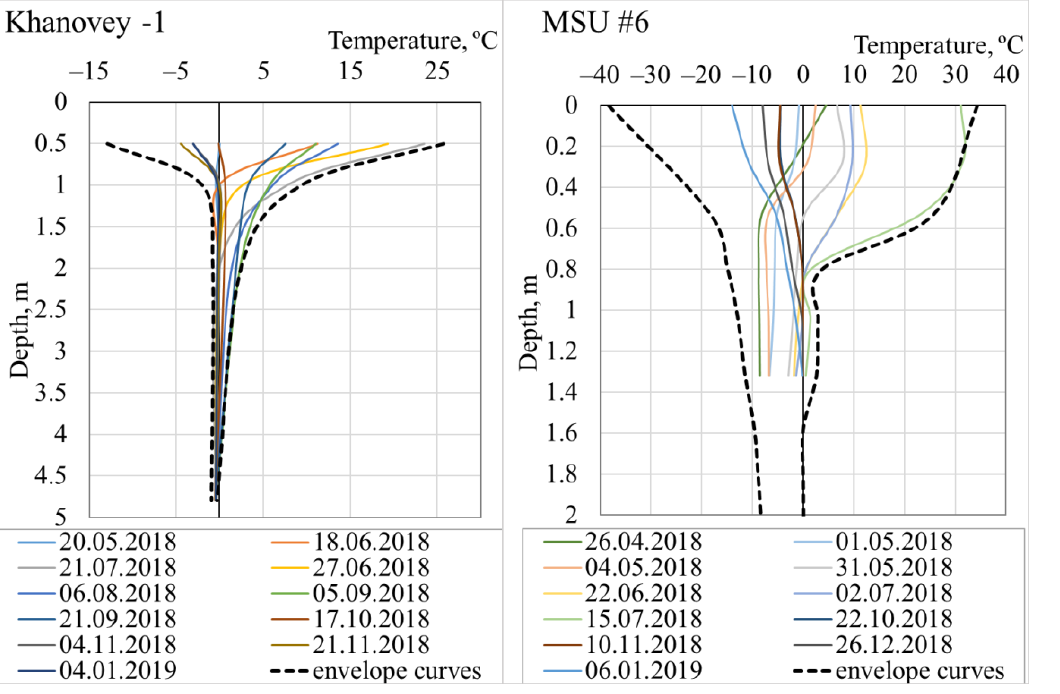
Figure 7. Ground temperature at the borehole Khanovey-1 at the Khanovey test site and the borehole MSU #6 at the Baydaratskaya Bay test site.